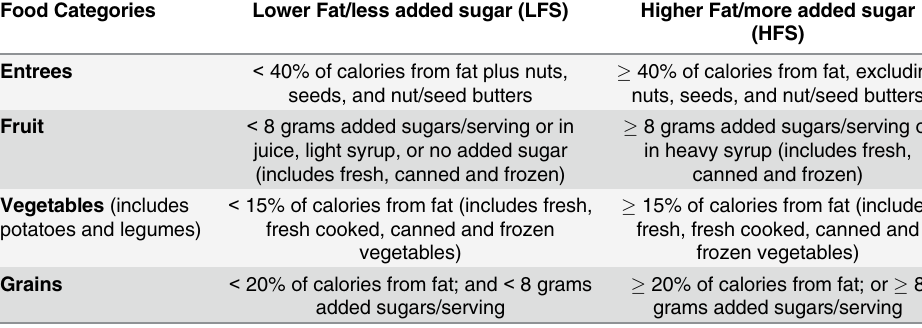
Table 1. Criteria developed by local health department dietitians for “ Lower Fat ” and “ Higher Fat ” food items in reimbursable school lunch meals. Food Categories Lower Fat/less added sugar (LFS)